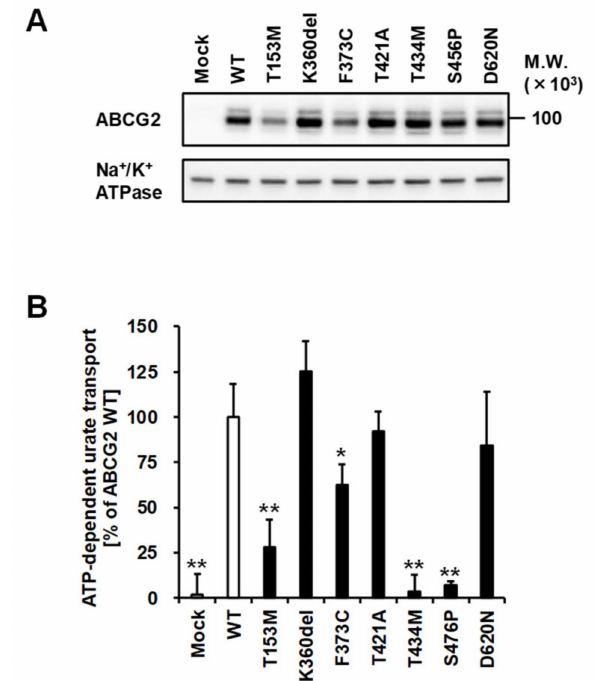
Figure 5. Functional validation of each ABCG2 variant as ATP-dependent urate transporters.